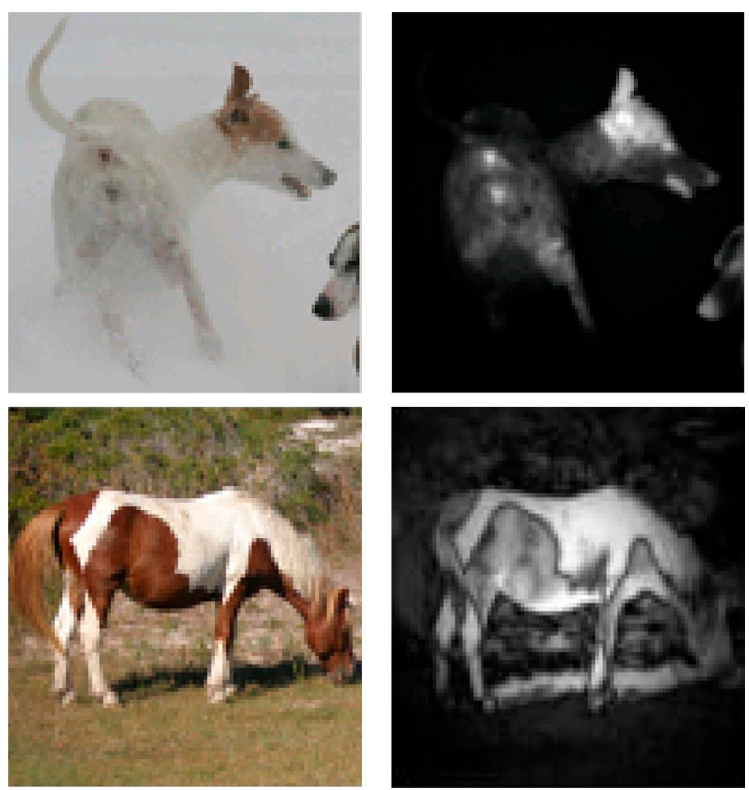
Figure 1. Two images from STL-10 dataset and its corresponding visual saliency map computed by using the saliency model proposed in [27].